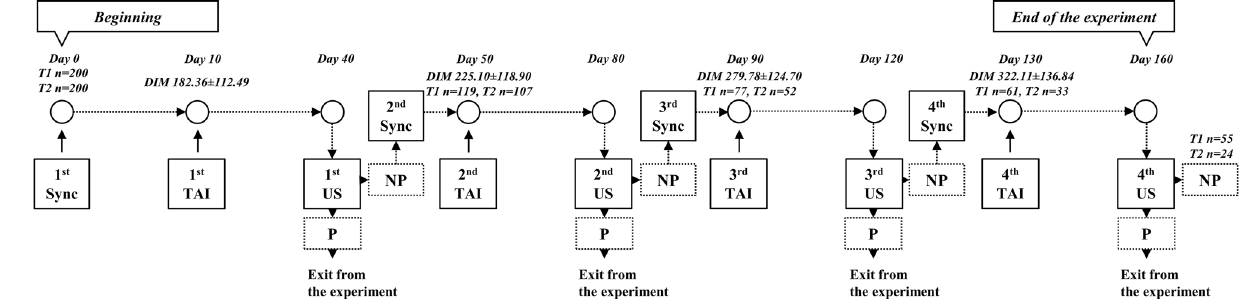
Figure 2. The experimental design. Cows were given a placebo or 400 mg/h/day of beta-carotene daily, from the 1st synchronization (day 0) until the experiment ended. Sync synchronization, TAI timed artificial insemination, P pregnant, NP non-pregnant, US ultrasound